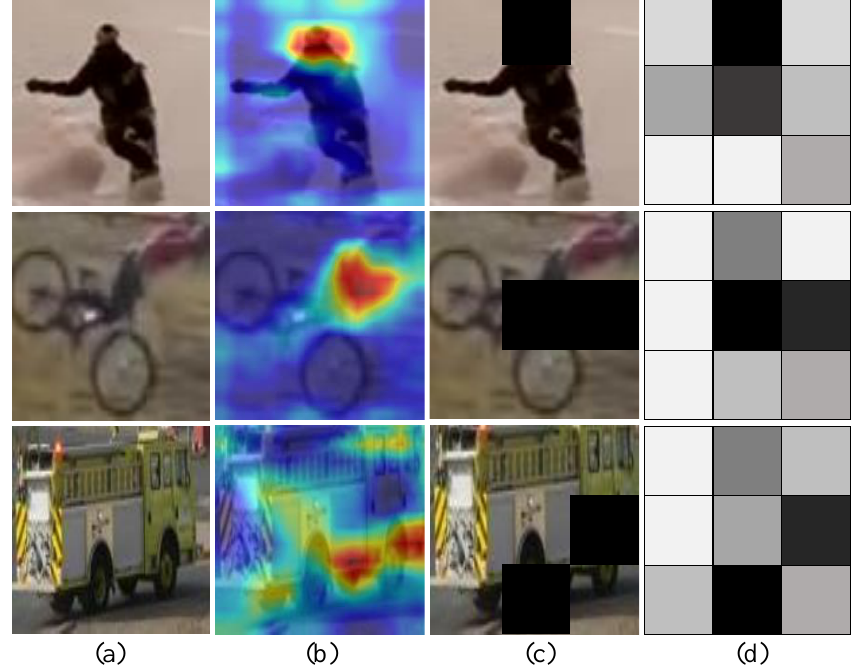
Figure 1. Principle of local feature selection and mask generation. In this paper, we propose to use an attention module and adversarial network to generate examples with occlusions and deformations that will be hard for the object tracker. The attention map is the visualization results of Grad-CAM [24] that learn the spatial attention of the target region. ( a ) Target region. ( b ) Attention map. ( c ) Mask template. ( d ) Generated